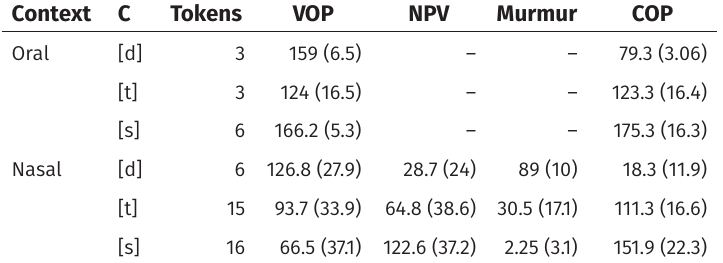
Table 6: Mean duration and standard deviation (in ms) of each portion by context and subsequent consonant (Data by Participant